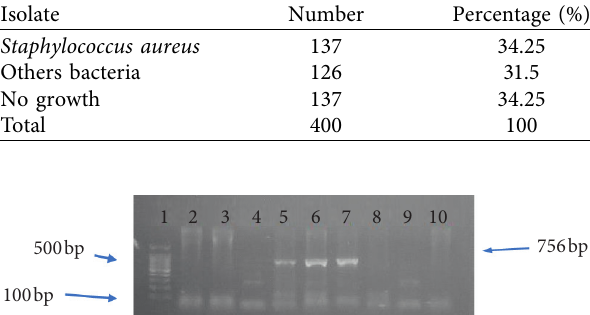
Table 3: Distribution of bacteria isolated from selected food samples purchased from retailers in Khartoum State.